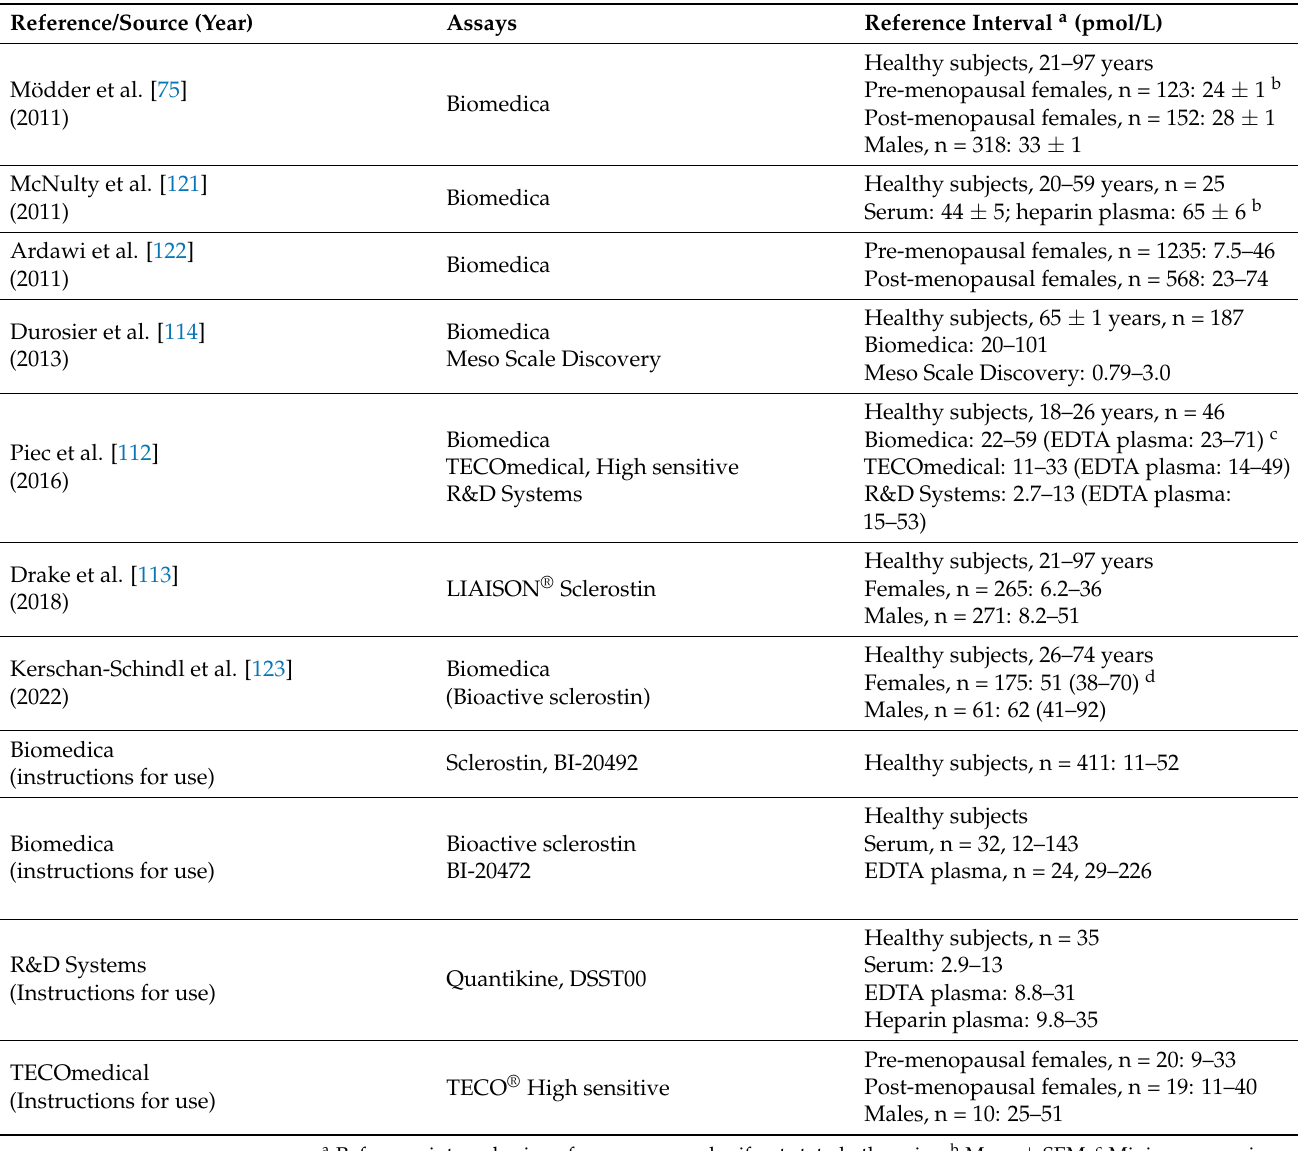
Table 2. Reported reference intervals for serum and plasma sclerostin in adult